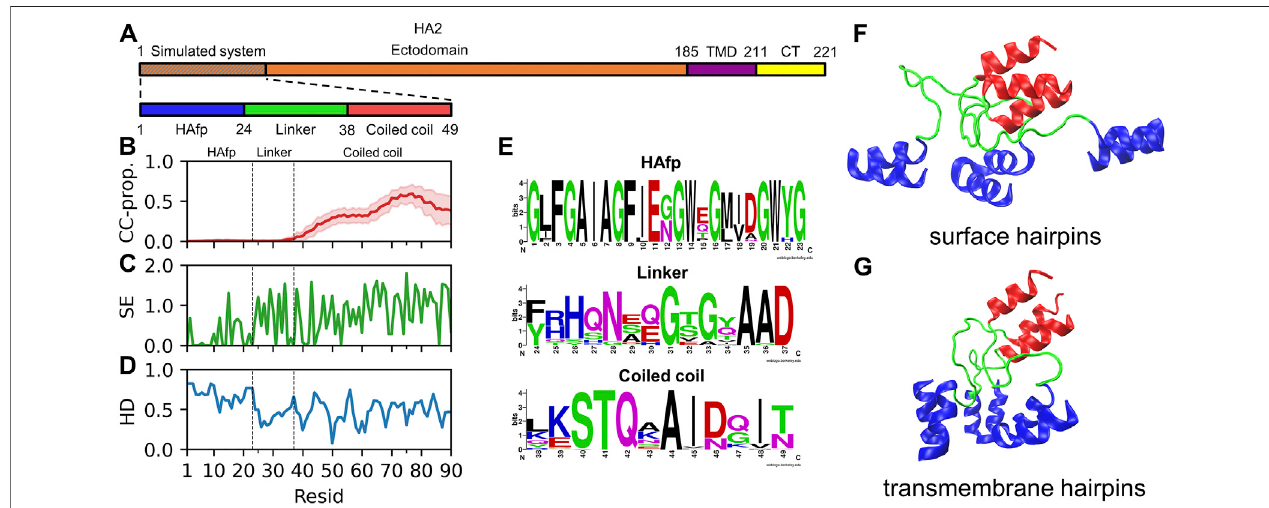
FIGURE1|(A) Schematicrepresentationofin fl uenzavirusHA2subunit. (B) Meancoiled-coilformingpropensity(CCprop.)ofHA2N-terminussequencevariants. Shadows correspond to one standard deviation. (C) Shannon entropy for HA2 N-terminus sequences. (D) Hydrophobicity of the considered HA2 N-terminus, normalised to span [0,1] range, along with increasing hydrophobic character. (E) Sequence conservation of HA2 N-terminus region. (F,G) Surface and transmembrane HAfp con fi gurations, respectively, after 5 μ s simulation time (randomly selected one out of four simulations in either